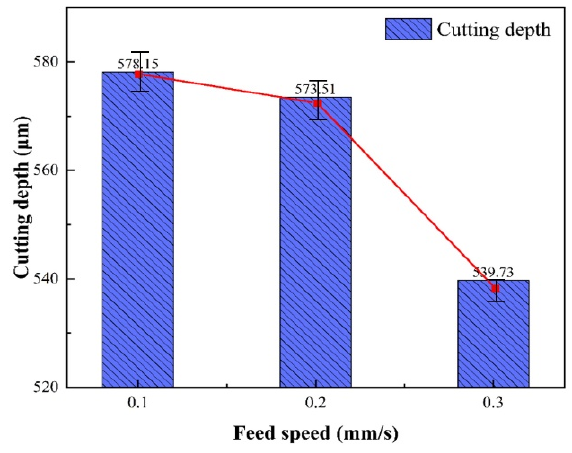
Figure 6. Cut section morphology.